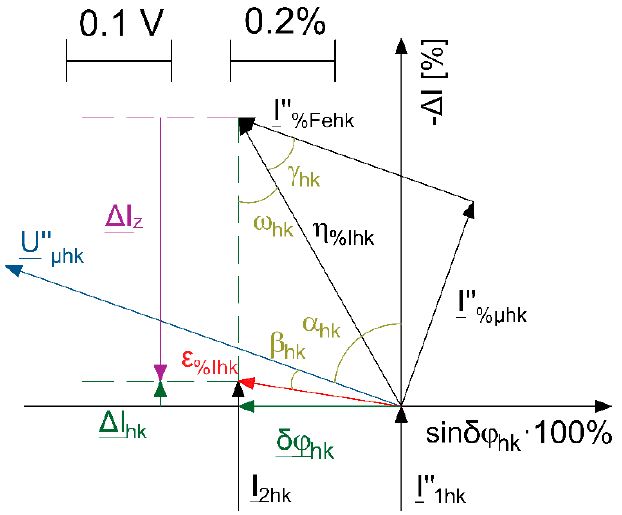
Figure 4. Vectorial diagram constructed for the inductive CT.